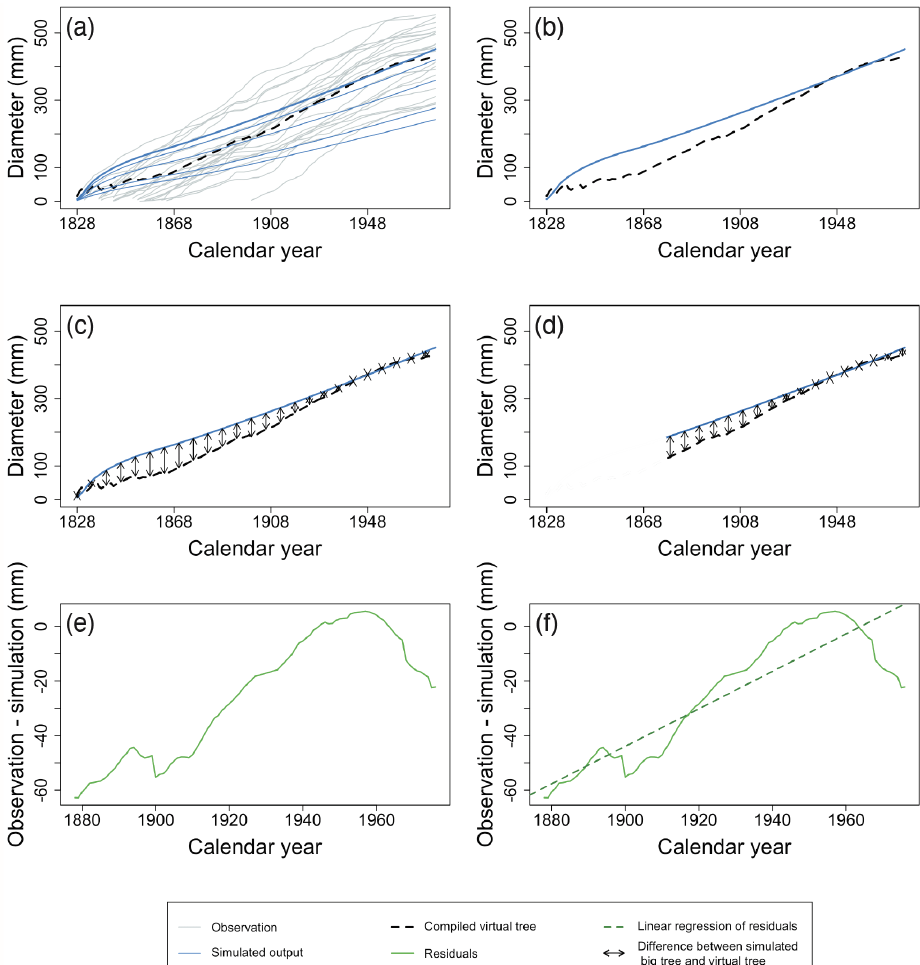
Figure 6. Example of the major steps in calculating the metrics of the benchmark for the diameter increment in mature trees. Individual tree records are ordered by calendar year, and the average observed diameter is calculated for each year (a) . Observations are shown as grey lines, and the simulation is shown as blue lines. The largest diameter class from the simulation is presented by the bold blue line. Black dotted lines represent the yearly average of observations. Note that the x axis in Fig. 6 is different from Fig. 5. Under the assumption that the observed trees are the biggest trees from a given site, the virtual tree is compared with the largest diameter class from the model (b, c) . Given that both the fast- and slow-growing trees are still alive and could have been sampled for the most recent decades, only the recent decades (10 decades, in this example) of the virtual-tree growth are compared to the simulations (d) . The RMSE ( d ; black arrows) and trend of the residuals between the virtual tree and the largest diameter class simulated are calculated (e, f) . From the whole period shown in panels (a) to (d) (1828–1976), the first 50 years were excluded, and panels (e) and (f) zoom in on the last 10 decades. The green line denotes the residuals, and the green dotted line is the linear regression of the model residuals. Observations and simulation are from a Pinus sylvestris site in Scotland, archived as brit021 (Schweingruber, 1995). In this case, the RMSE (d) and the slope of residuals (f) were calculated as 33.65mm and 0.68mmyr − 1